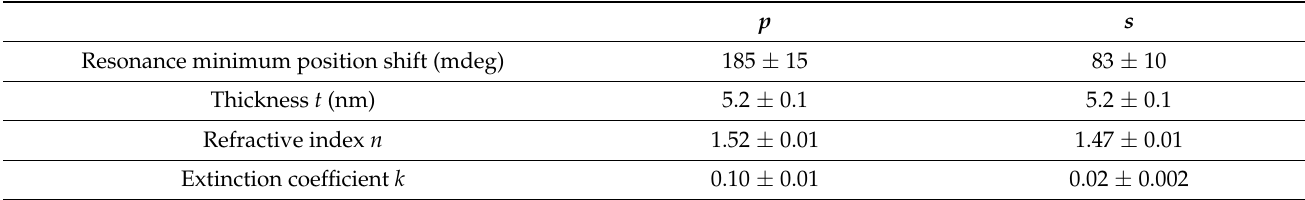
Table 1. Optical parameters obtained for a solid-supported lipid bilayer composed of an egg PC